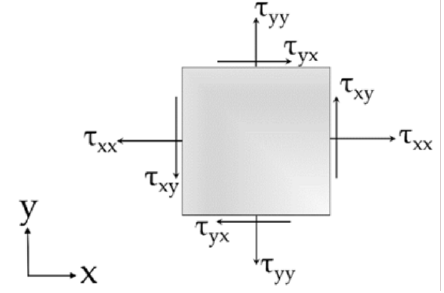
Figure 2. The shear stress in two